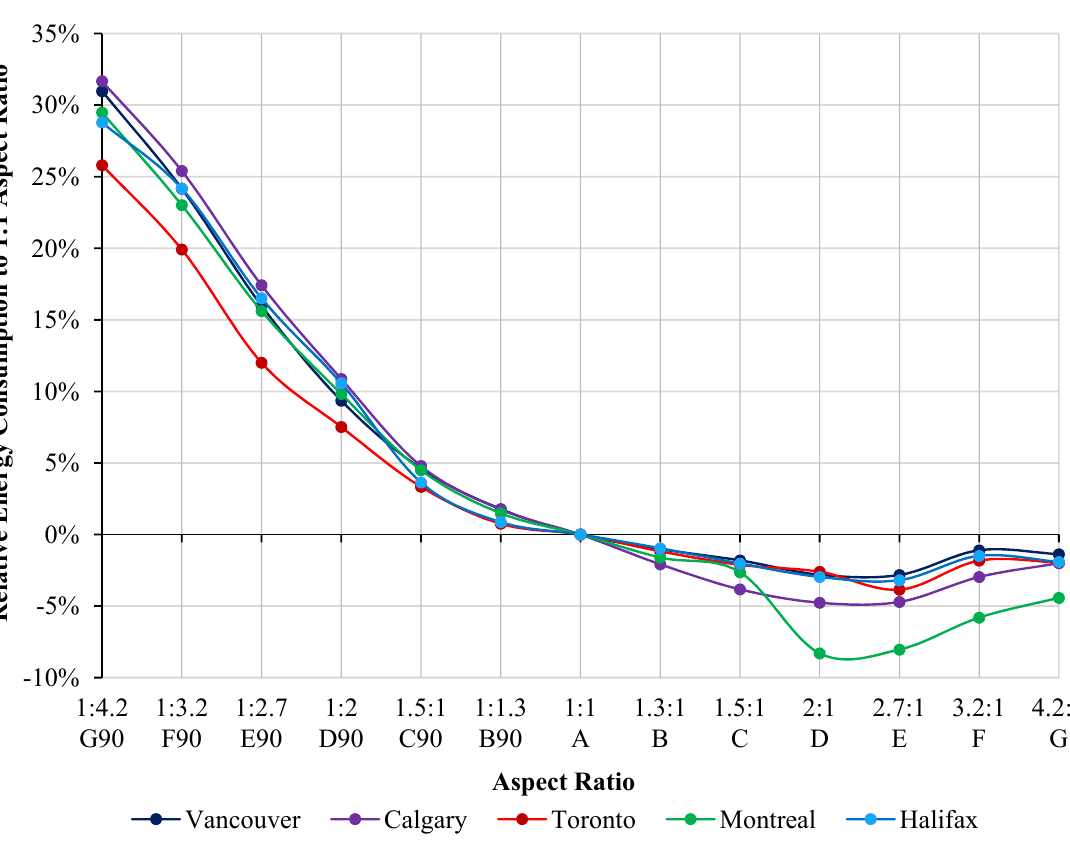
Figure 15. Relative energy consumption in cooling for aspect